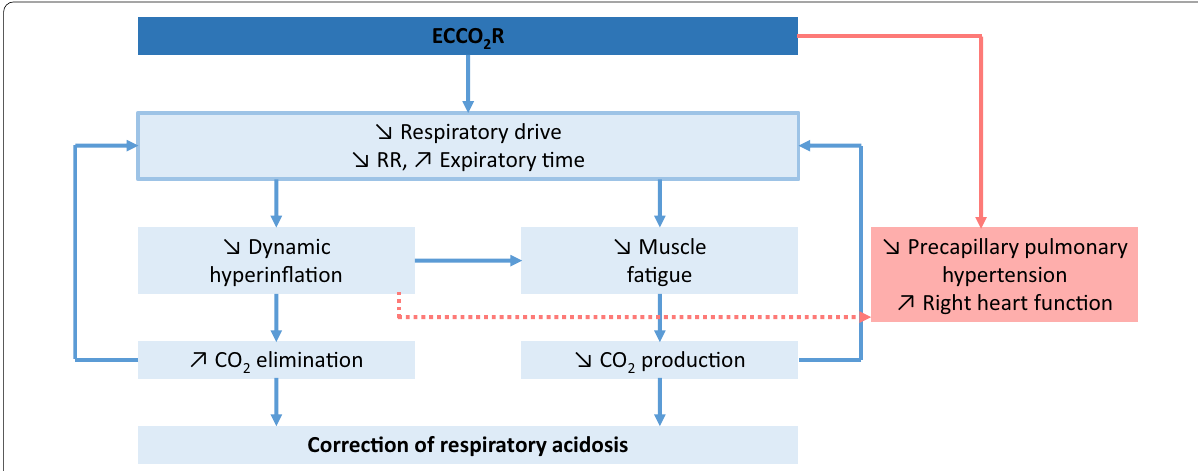
Fig. 1 Pathophysiological rationale for the use of ECCO 2 R in COPD